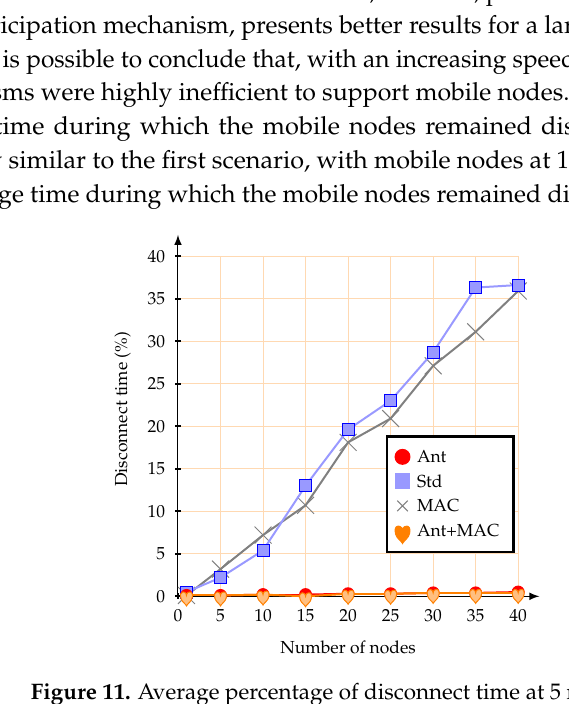
Figure 11. Average percentage of disconnect time at 5